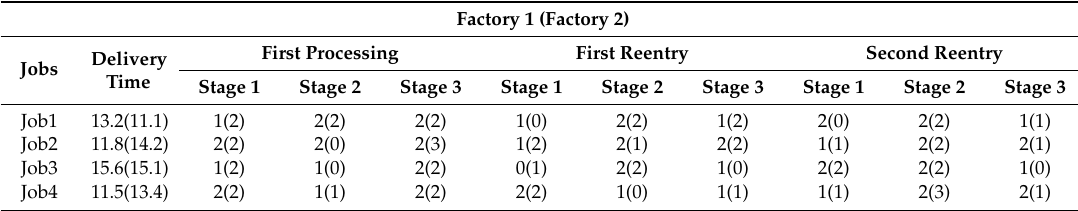
Table 3. Processing time and delivery time of each